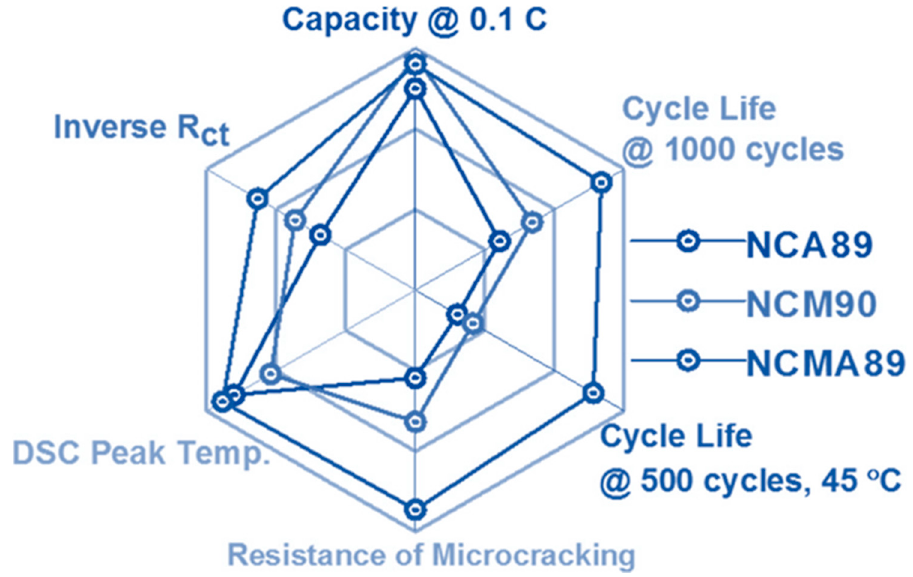
Figure 18. Li[Ni 1–x–y Co x Al y ]O 2 (NCA) and Li[Ni 1–x–y Co x Mn y ]O 2 (NCM) cathodes have been